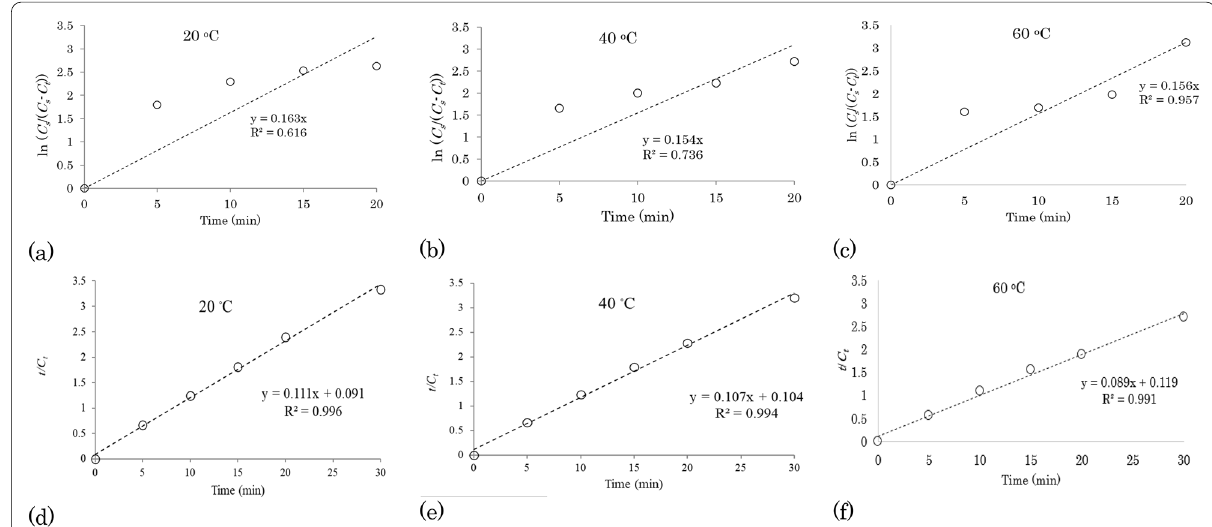
Fig. 3 First-order kinetic models ( a – c ) and second-order kinetic models ( d – f ) of extraction of total polyphenolic compounds from apple pomace with 65% acetone–35% water v/v at different